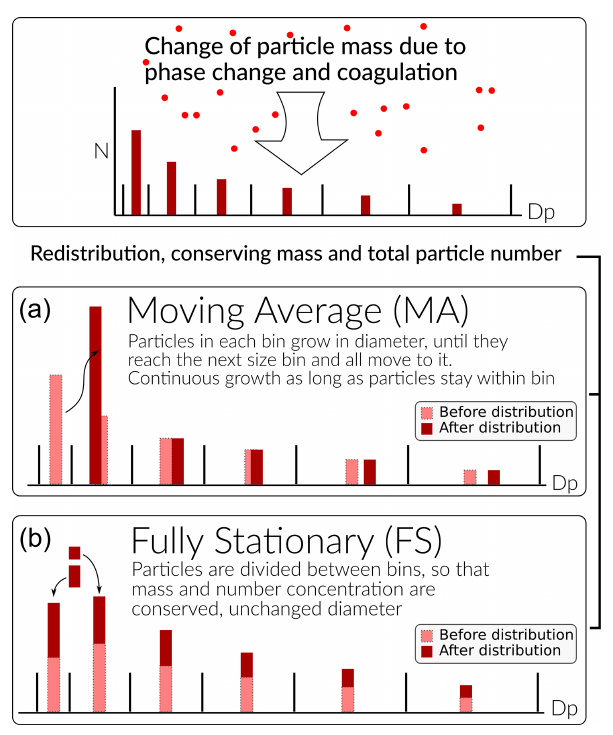
Figure 4. Schematic of the two particle size distribution representa- tions: the fixed-grid moving average (MA, a ) and the fully station- ary (FS, b